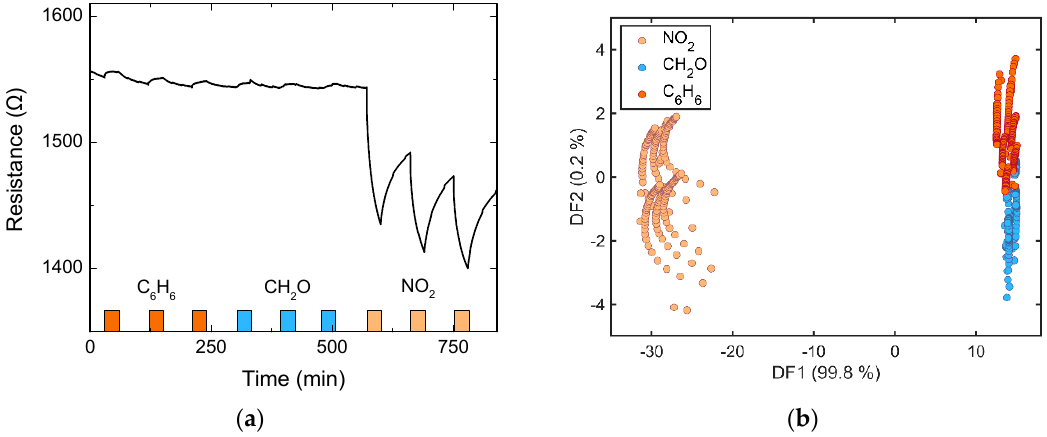
Figure 6. ( a ) Resistance over time of V 2 O 5 NL DEG towards 200 ppb of C 6 H 6 , CH 2 O, and NO 2 at 0% RH and 150 °C and ( b ) linear discriminant analysis (LDA) based on gas exposures of all four sensors.